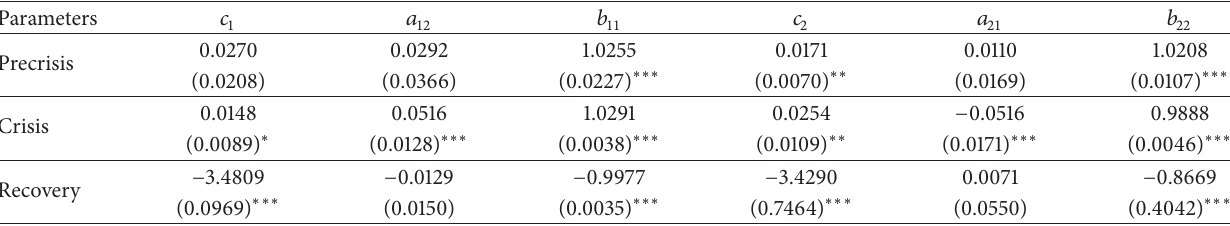
Table 5: Financial contagion analysis between the US and UK.